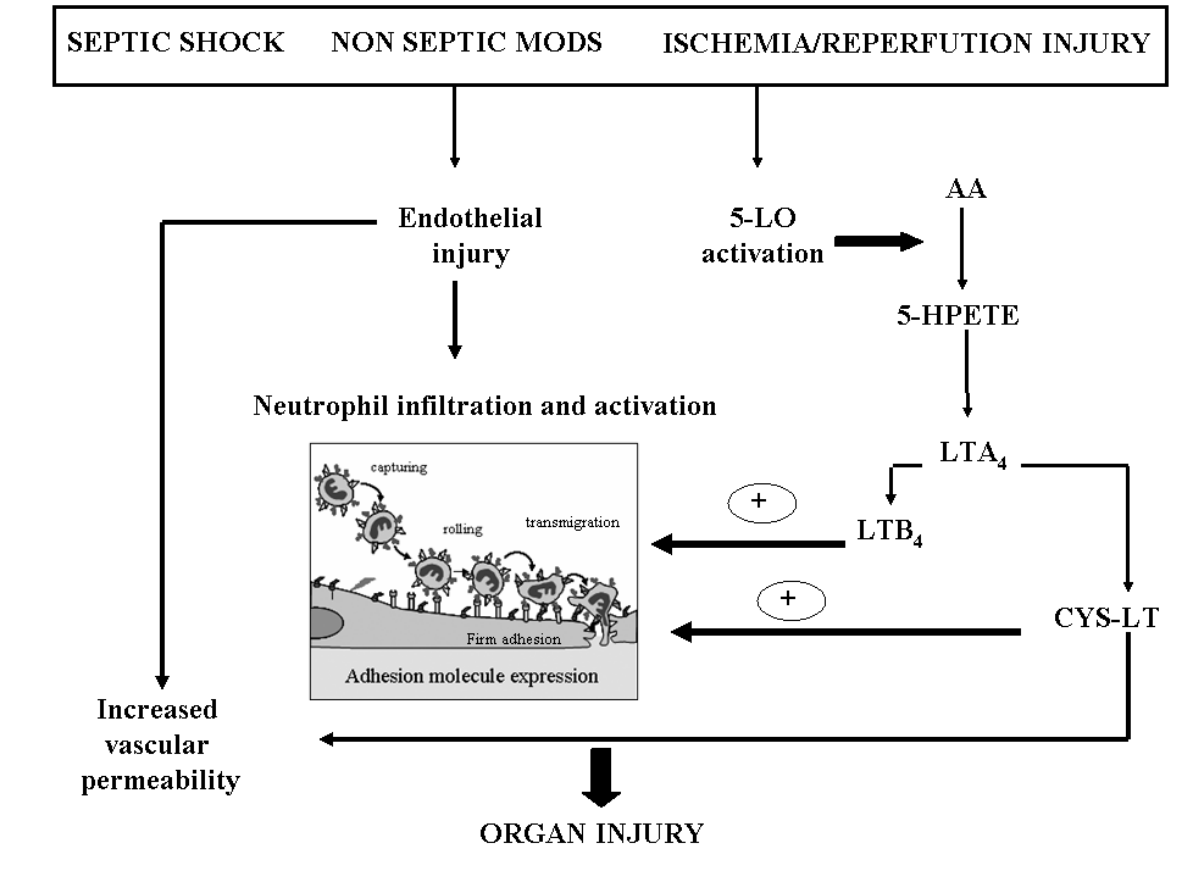
FIGURE 1. Proposed scheme for the role of 5-LO in septic shock, nonseptic MODS, and I/R